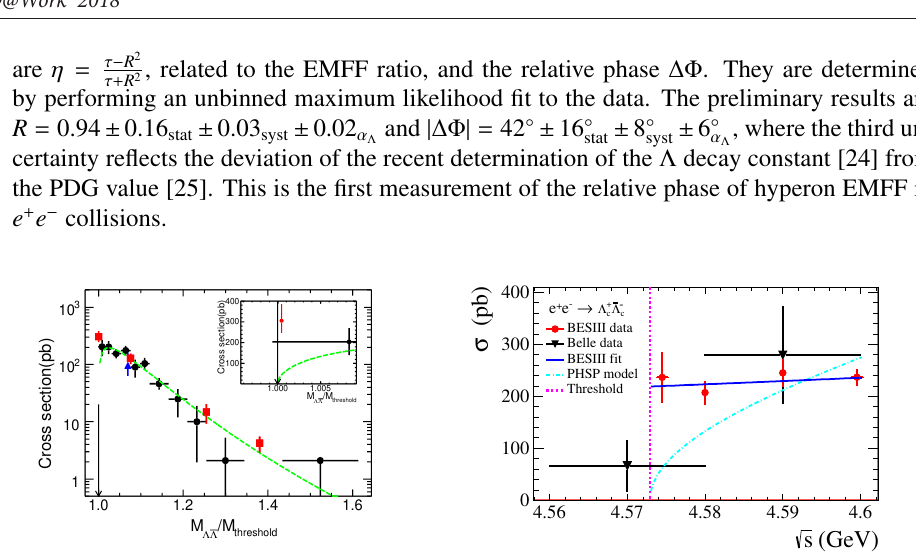
Figure 3. left: (From Ref. [22]) The Born cross section of e + e − (black) and DM2 (blue). The green line shows a fit with a pQCD prediction. right: (From Ref. [26]) The Born cross section of e + e −